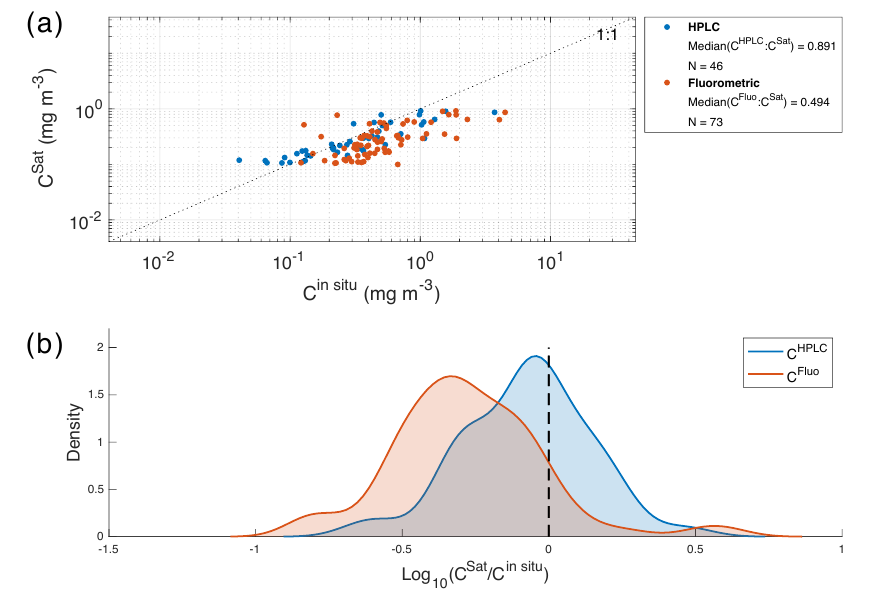
Figure 3. ( a ) Comparison between measured (C insitu ) and retrieved (C Sat ) chlorophyll-a for box 1 with a time window of 12 h. Blue and orange dots indicate samples measured from HPLC (C HPLC ) and fluorometry (C Fluo ) respectively, while the dashed line shows the 1:1 relationship. ( b ) Probability density function of the logarithm base 10 of the ratio between C Sat and C insitu from fluorometry (blue line) and HPLC (orange line); with the statistics of the comparisons listed in Table 2.